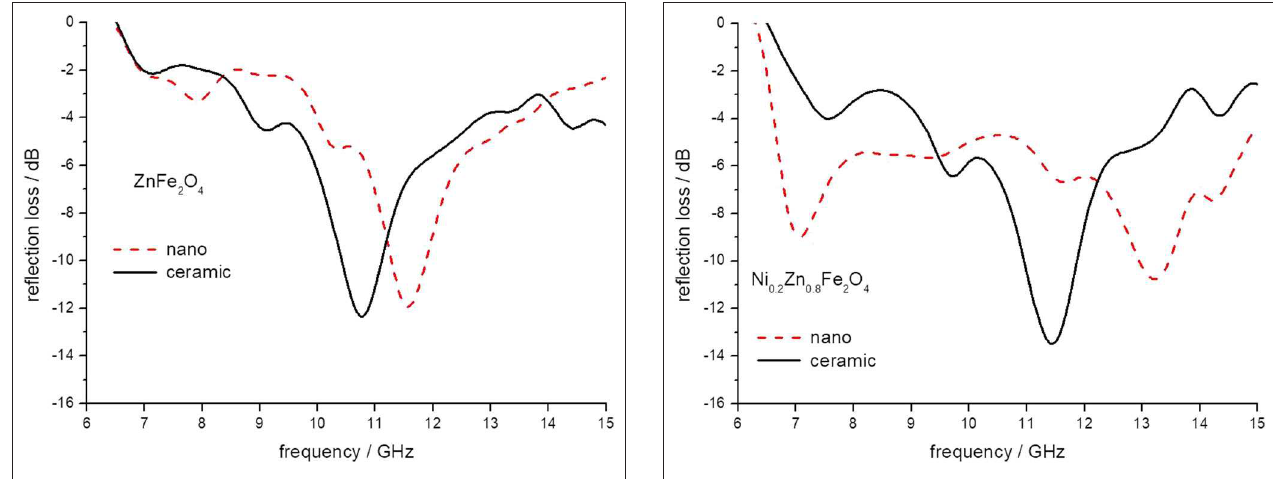
FIGURE 5 | The reflection loss of epoxy composite containing ceramic and nanoparticles of ZnFe 2 O 4 ferrites.